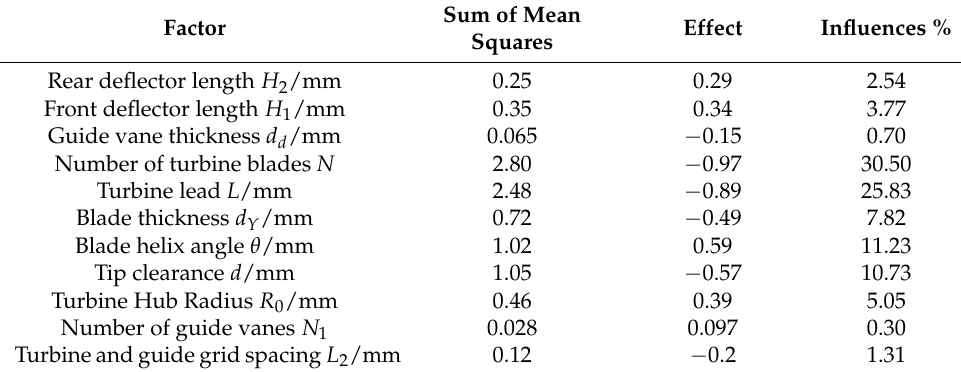
Table 4. Influence degree of factors.